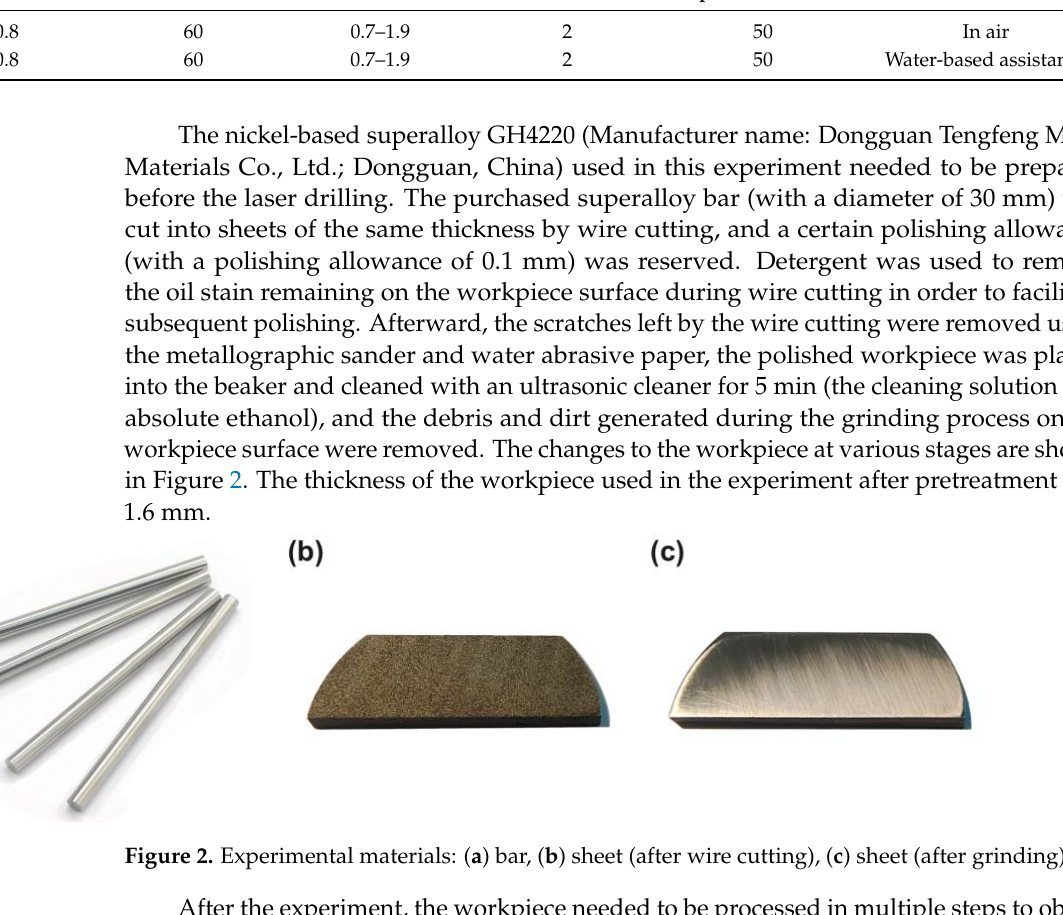
3 of 12 Figure 1. Schematic diagram of millisecond laser trepanning with water-based assistance. Table 1. Laser parameters used in air and water-based assistance. Case Pulse Duration (ms)